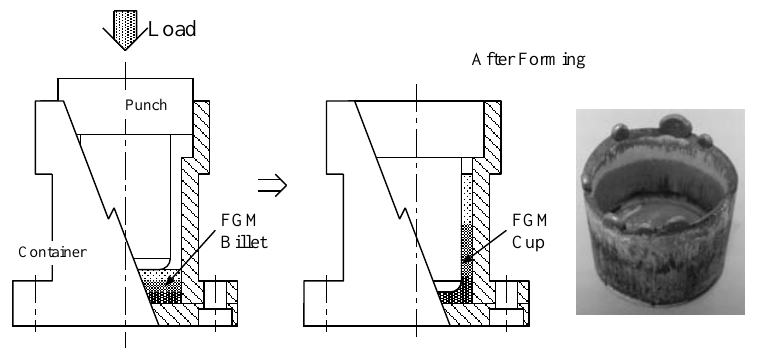
Figure 3. Schematic illustration for FGM semisolid forming